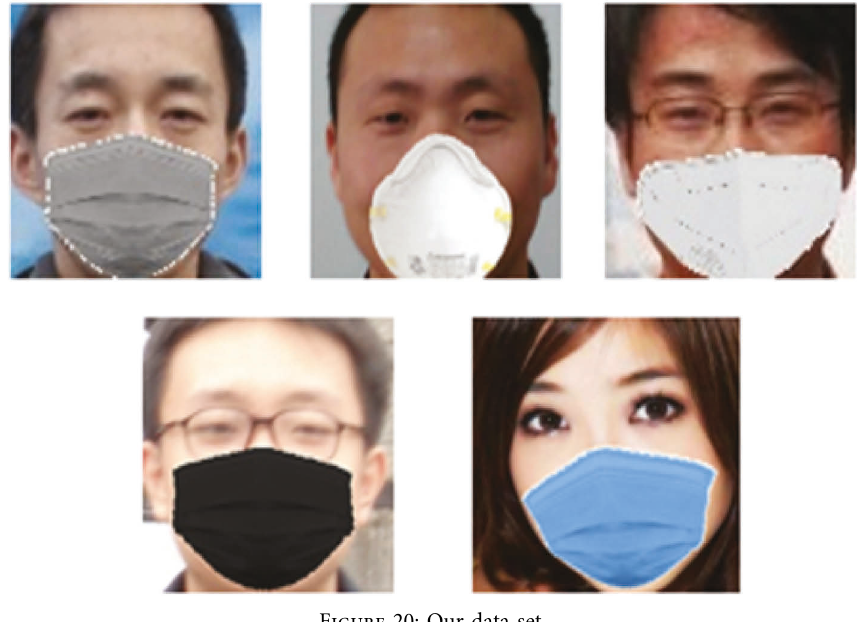
Figure 20: Our data set.